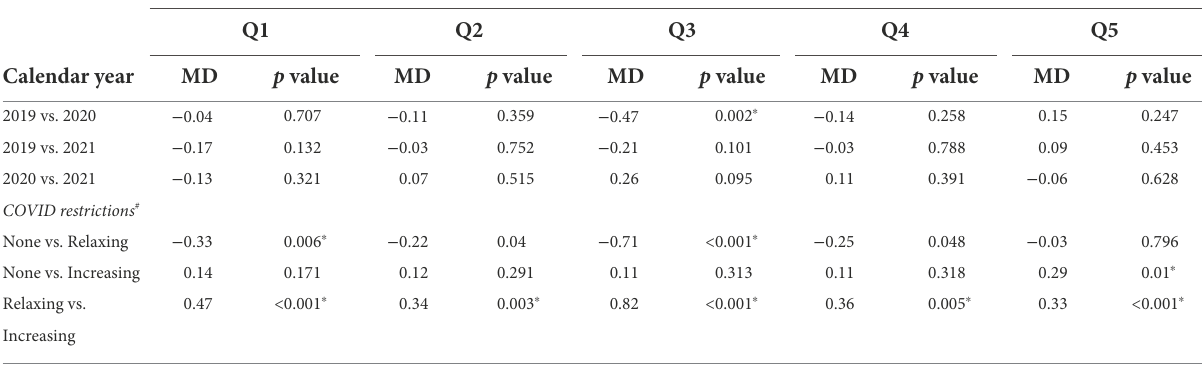
TABLE 3 Comparisons of means in each feedback domain for both courses (PATH3205 and PATH3206), arranged according to calendar year and then regrouped according to prevailing COVID restrictions at the time of teaching. Grouping